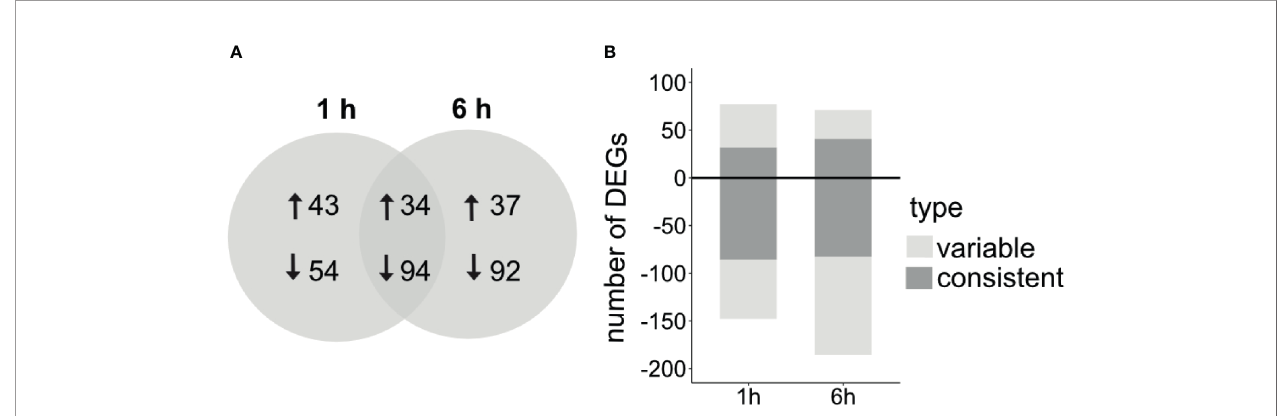
FIGURE 3 | (A) Number of DEGs comparing LPS treated versus control sponges and the overlap between the two time points after LPS exposure, 1 h and 6 h after treatment. Arrows indicate up- and downregulation in comparison to control treatment. (B) Proportion of consistent and variable DEGs (with consistent/variable expression patterns across replicate samples, see Methods ). Total DEGs 1 h: 225, total DEGs 6 h: 257 (genes de fi ned as differentially expressed with FDR p-value < 0.005 and log2|FC| ≥